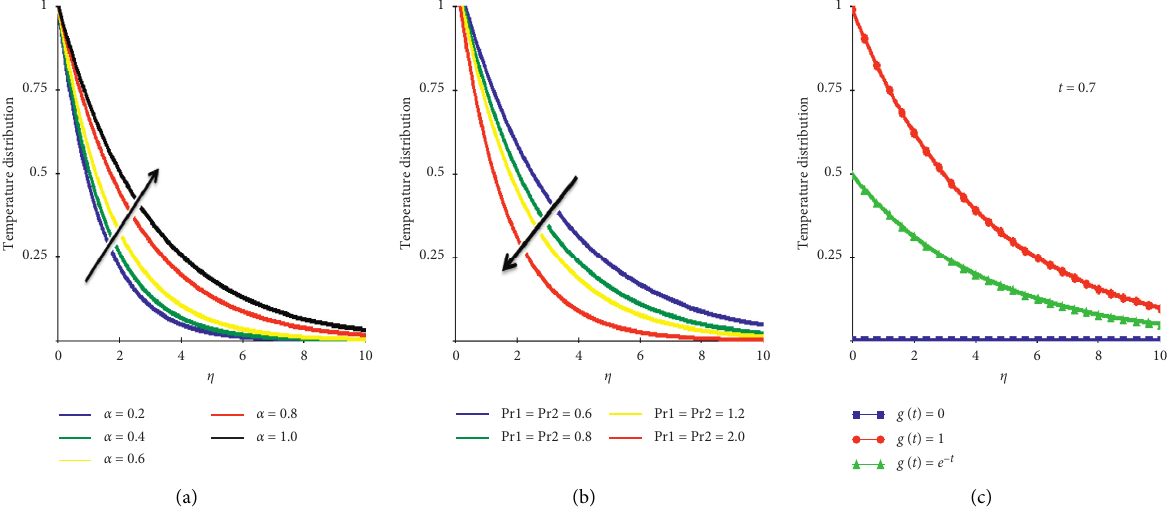
Figure 4: Sketch thermal profile for changing α , Pr, and g ( t ) .